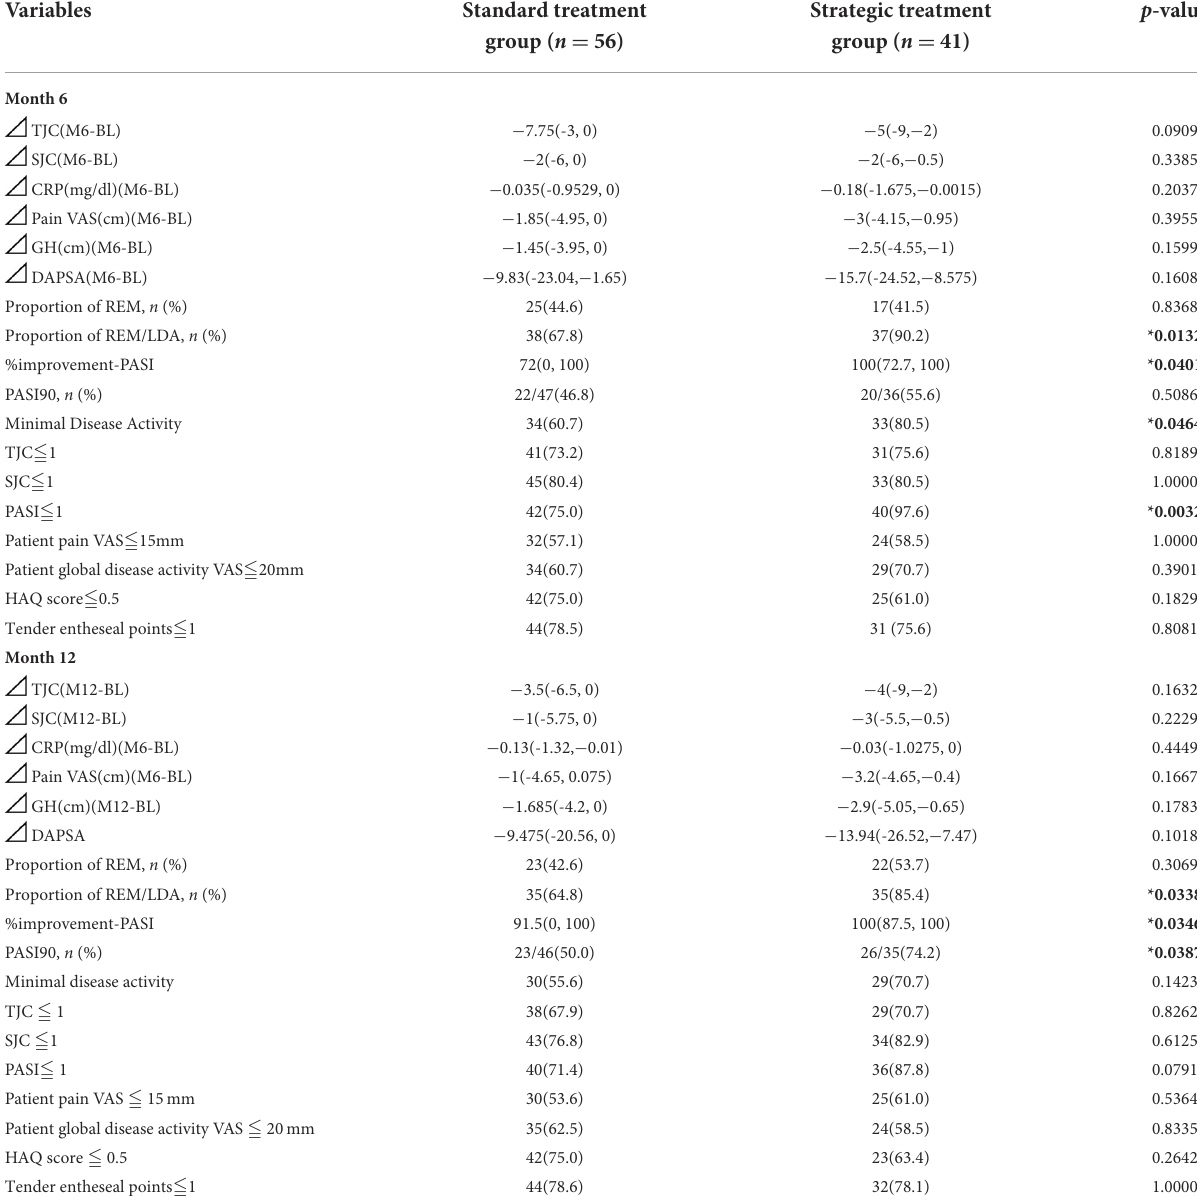
TABLE 2 Comparison of treatment response between 2